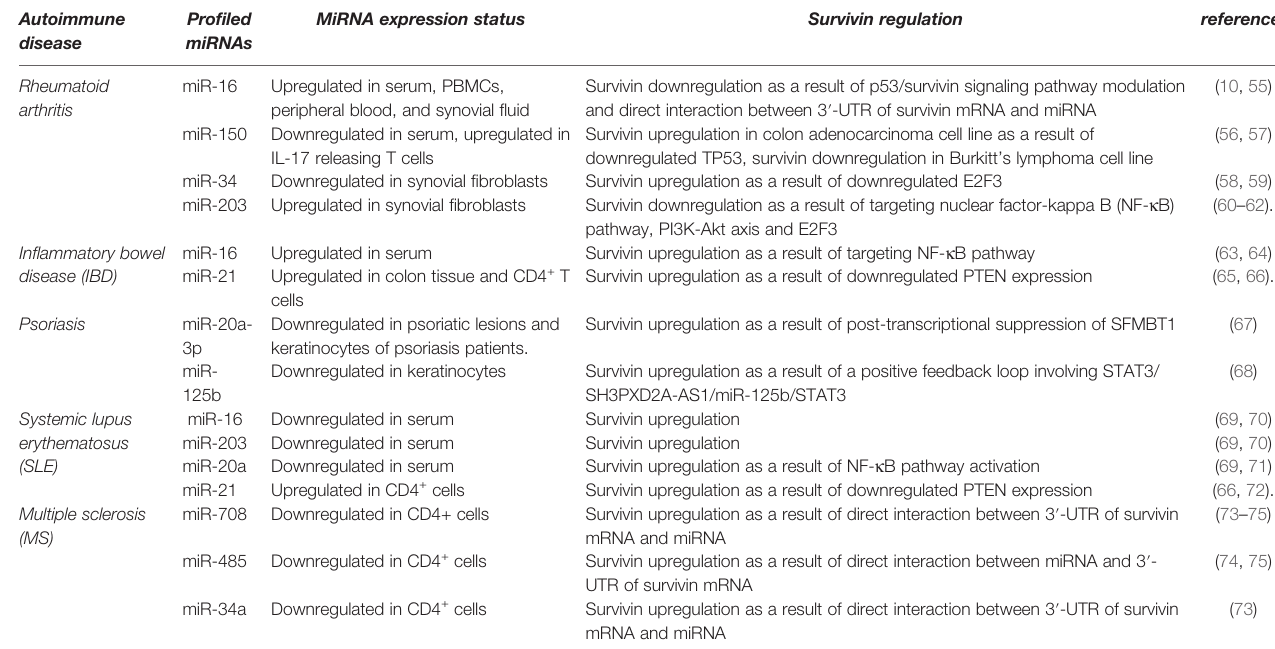
TABLE 1 | Dysregulation of Survivin-targeting microRNAs in various autoimmune diseases. Autoimmune